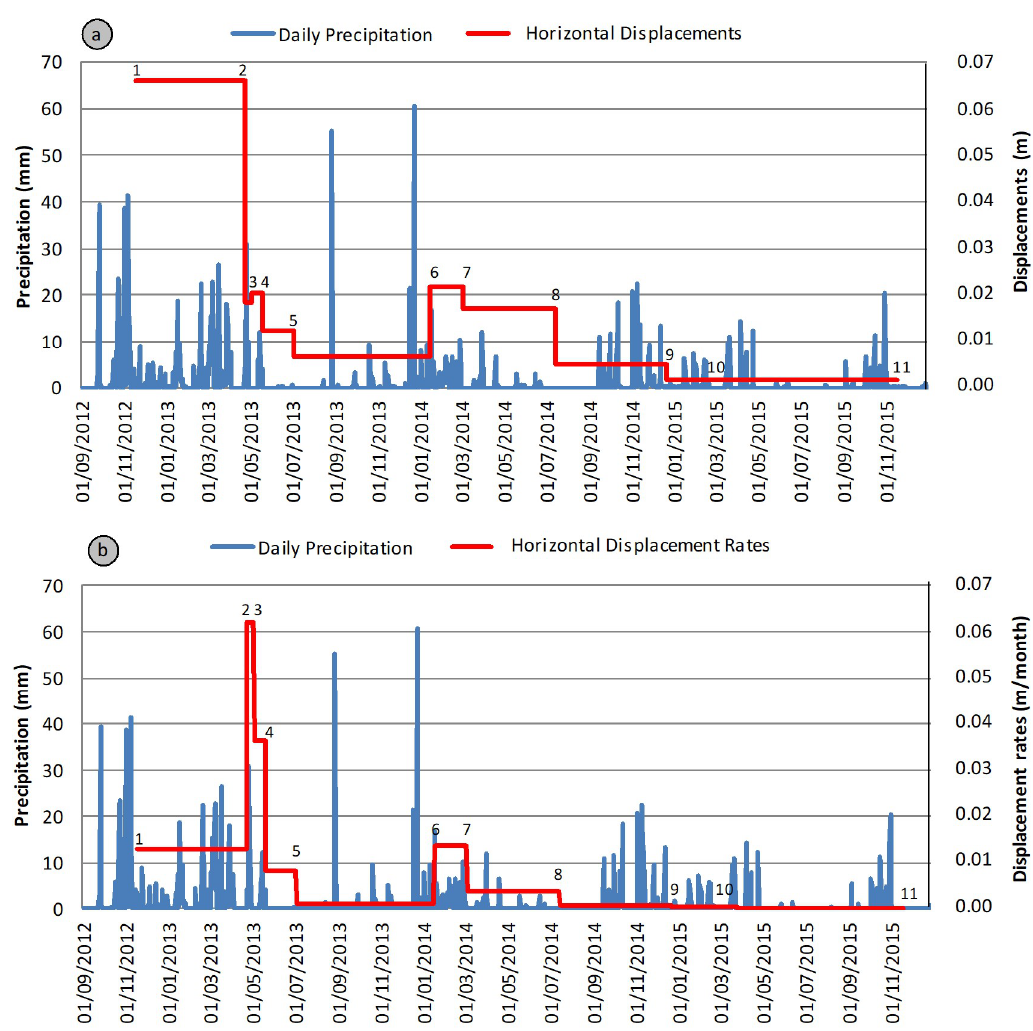
Figure 8. Relationships between the horizontal displacements and the rainfalls in the study period considered. ( a ) Displacements and rainfalls; ( b ) Displacements rates and rainfalls. Numbers indicate the measurement epoch (1 to 11).